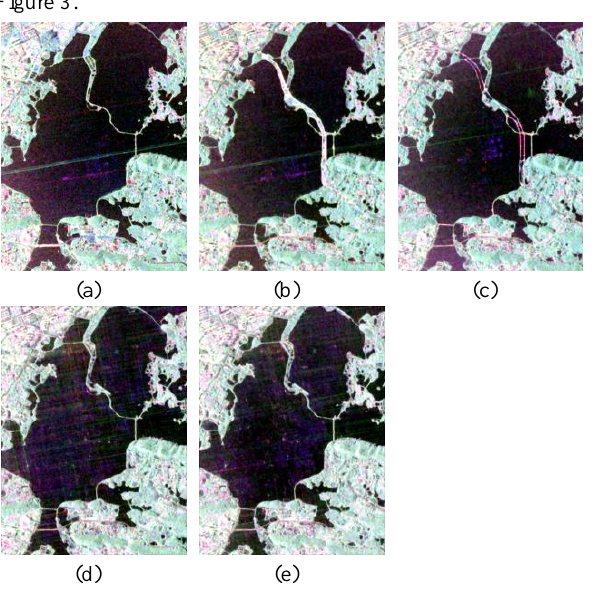
Figure 4. Time-series change detection over tunnel of East Lake from 2011 to 2017(a) between December, 2011 and June, 2015.(b) between December, 2011 and July, 2016.(c) between June, 2015 and July, 2016.(d) between December, 2011 and April, 2017.(e) between June, 2015 and April, 2017.(f) between July, 2016 and April, 2017.(g) between December, 2011 and May, 2017.(h) between June ,2015 and May, 2017.(i) between July ,2016 and May, 2017.(j)between April, 2017and May,